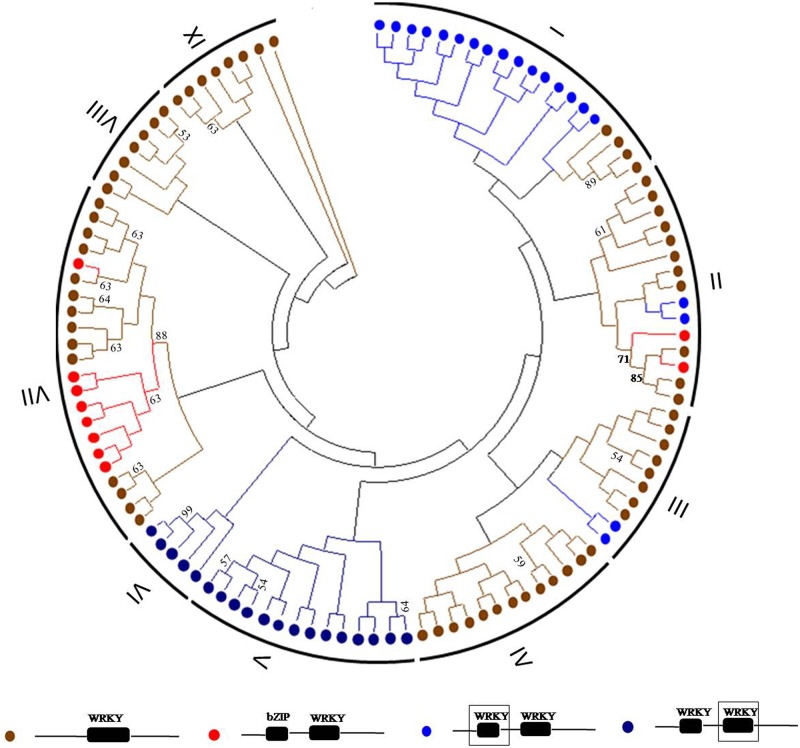
Phylogenetic tree obtained from the neighbour-joining analysis of conserved WRKY motifs from 95 EgWRKY genes.EgWRKYs that contain only one WRKY domain are marked with brown circles; EgWRKYs that contain conserved WRKY and bZIP domains are marked with red circles; EgWRKYs that contain two conserved WRKY domains are marked with blue circles.